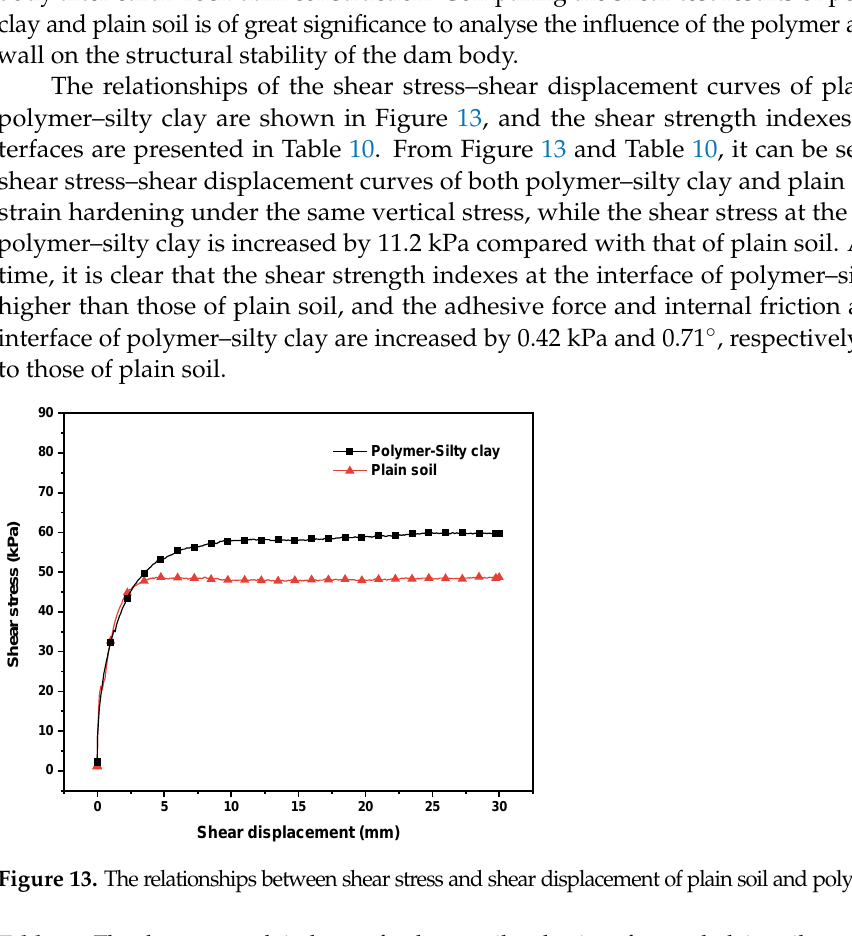
Table 10. The shear strength indexes of polymer–silty clay interface and plain